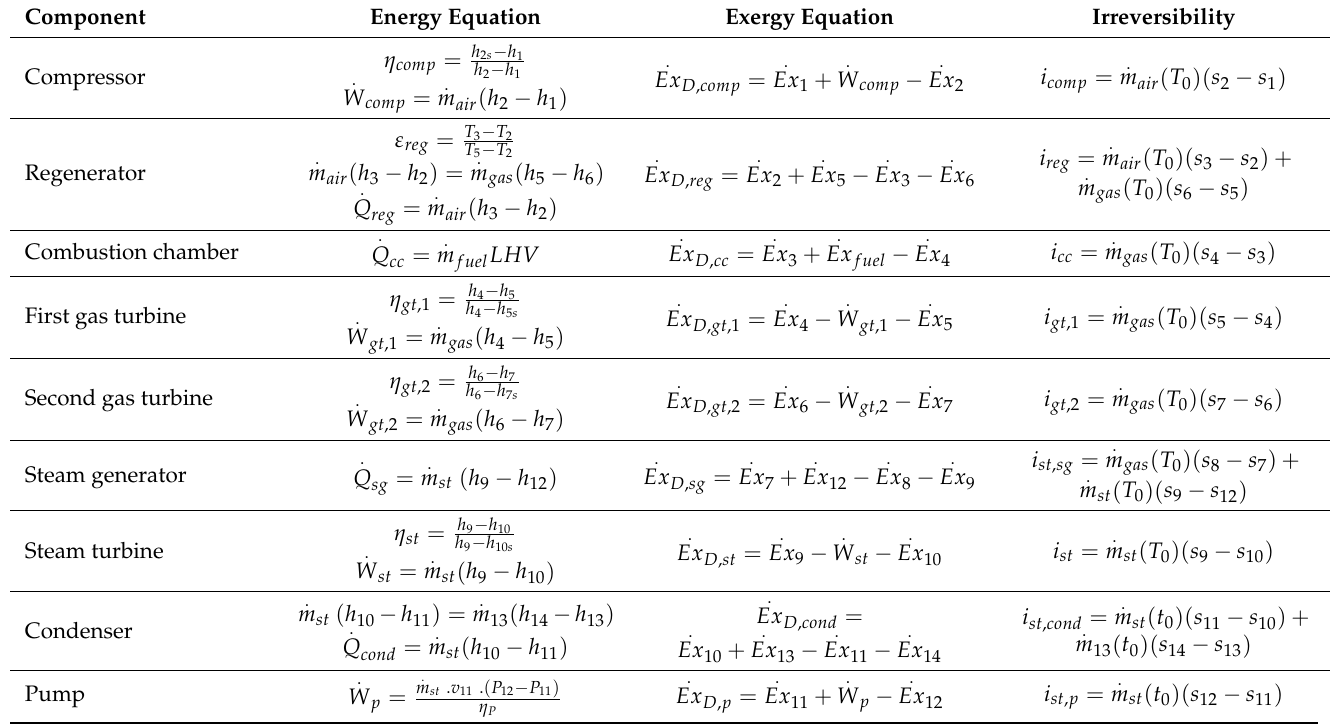
Table 2. Energy and exergy relations used in the combined cycle system shown in Figure